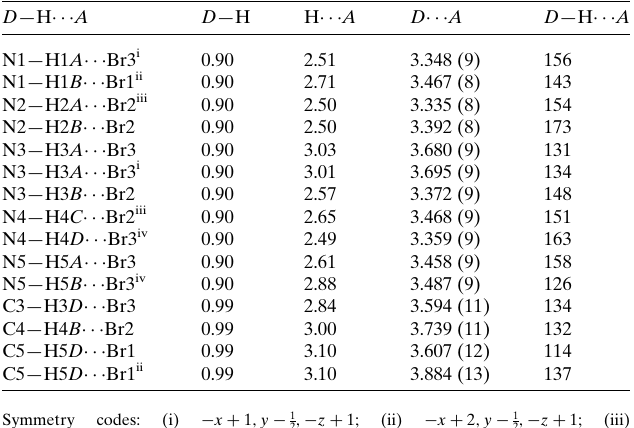
(Table 1) link the molecules into a three-dimensional frame- work, as shown in Figs 2 and 3.